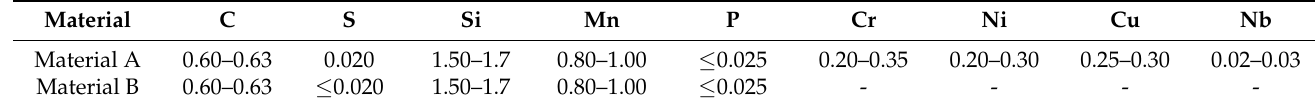
Table 1. Chemical composition of spring steel (Mass Fraction, %).